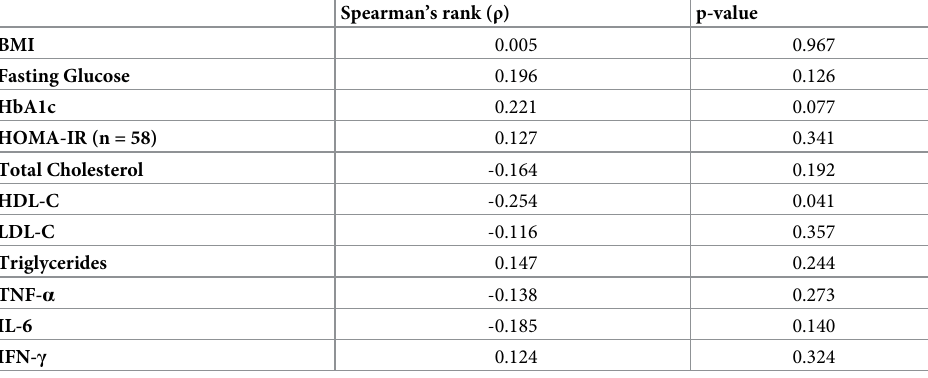
Table 2. Spearman’s rank correlations with plasma Nrg4 levels and metabolic parameters in NAFLD patients (n =